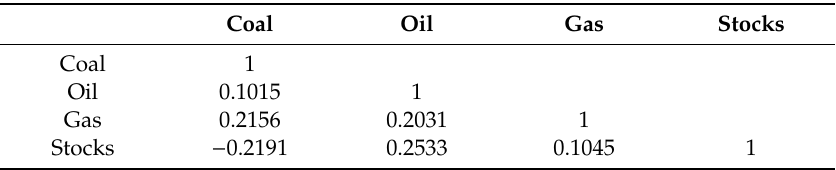
Table 10. Correlations for